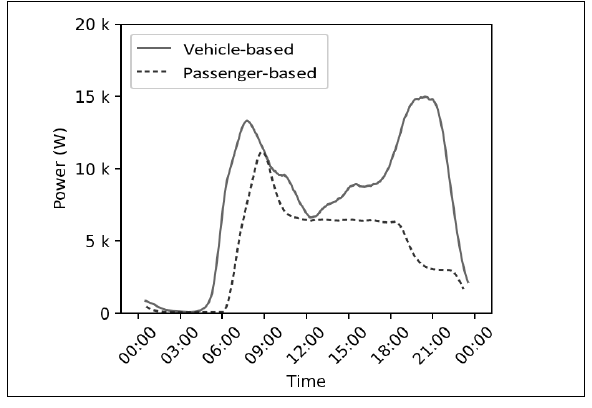
Figure 4: Comparison of Kampala per-vehicle power profiles derived from passenger-based and vehicle-based data. The differences are stark. First, it is clear that the taxis started moving between 4:00 and 5:00, before the fieldworkers managed to get on